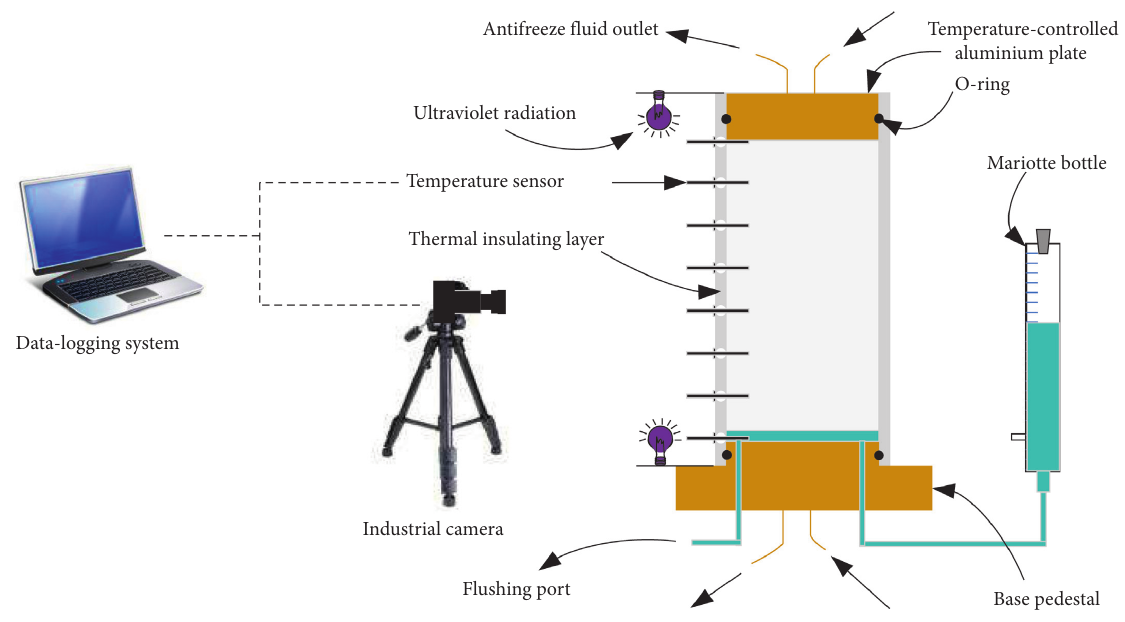
Figure 1: Liquid water-vapor migration test device.